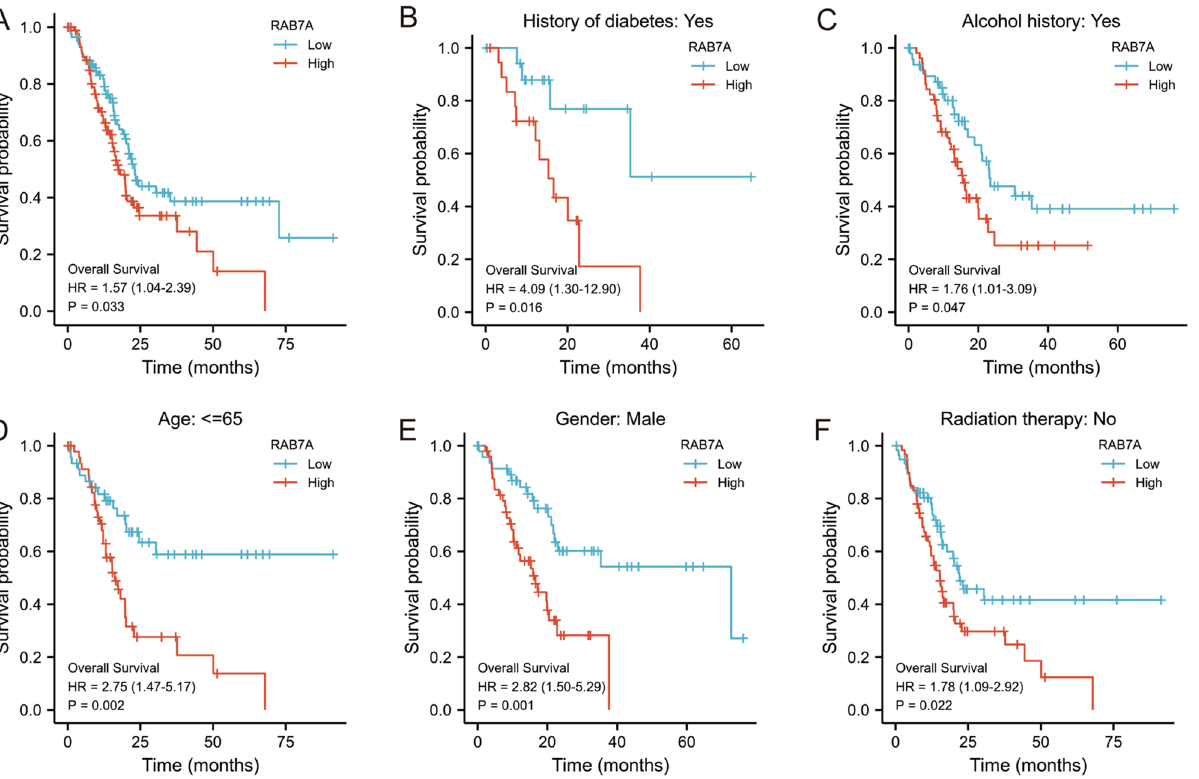
Figure 8. RAB7A overexpression was associated with a poorer OS in PAAD patients. ( A ) Kaplan–Meier curves for all PAAD patients. ( B ) Kaplan–Meier curves for PAAD patients with a history of previous diabetes mellitus. ( C ) Kaplan–Meier curves for PAAD patients with a history of previous alcohol consumption. ( D ) Kaplan–Meier curves for PAAD patients ≤ for 65 years. ( E ) Kaplan–Meier curves for male PAAD patients. ( F ) Kaplan–Meier curves for PAAD patients who did not receive